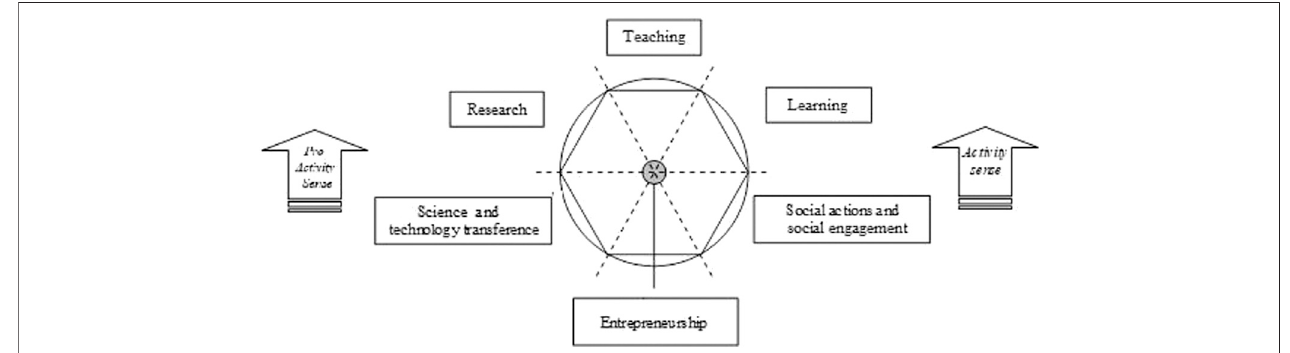
FIGURE 2 | The Sextuple Helix Model of the KT sequential and cyclical activities in higher education (Cavaller, 2020).